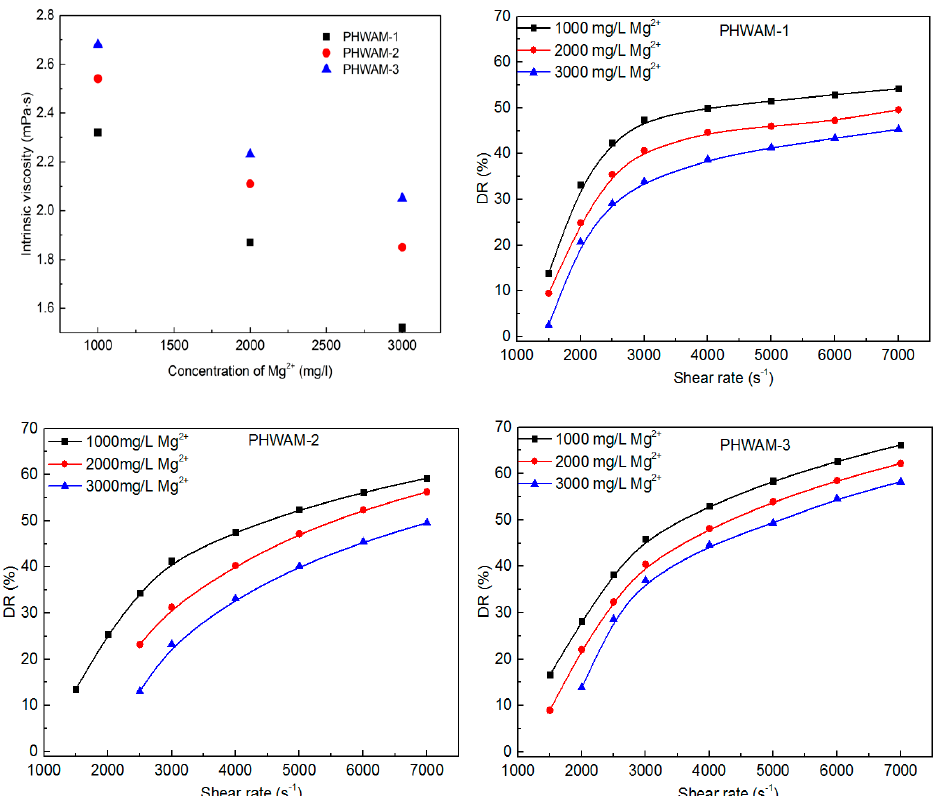
Figure 16. Viscosity and DR properties of 0.15 wt.% drag reducers in brine (10 × 10 4 mg/L) with different Mg 2+ concentrations: 1000 mg/L, 2000 mg/L, and 3000 mg/L. Table 4. The effect of Mg 2+ on samples in brine (10 × 10 4 mg/L). Sample of